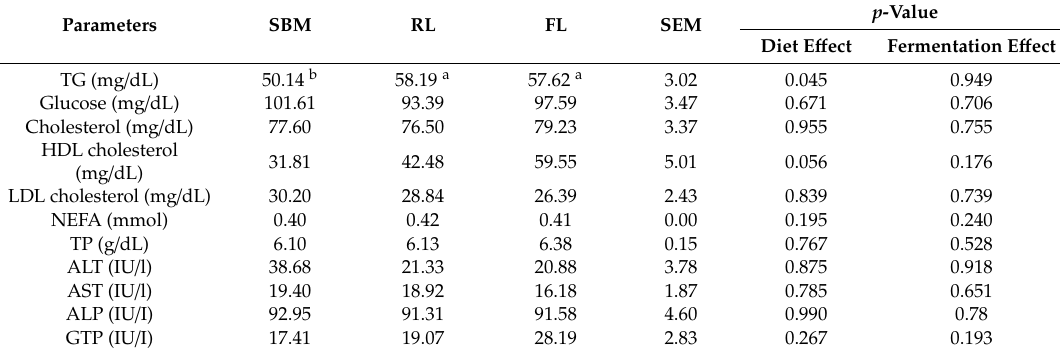
Table 8. Biochemical blood indexes in